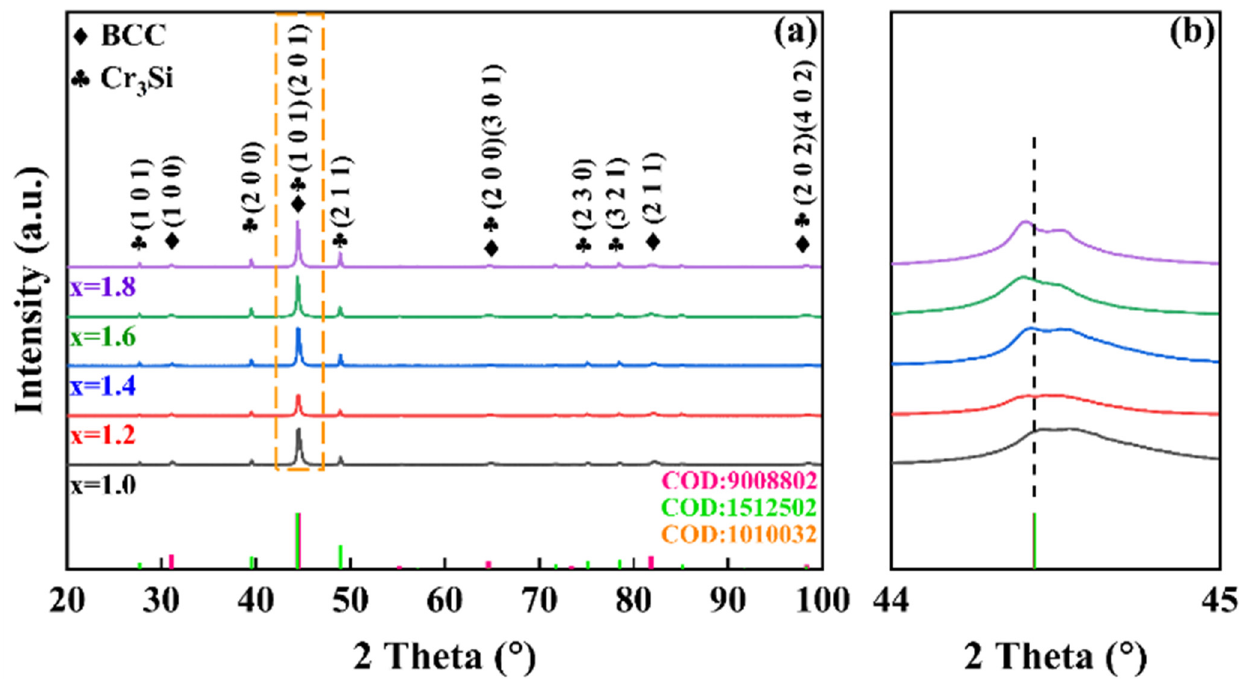
Figure 1. XRD patterns of AlSi 0.5 Cr x Co 0.2 Ni (x = 1.0, 1.2, 1.4, 1.6, and 1.8) high entropy alloys; ( a ) The phase composition of AlSi 0.5 Cr x Co 0.2 Ni HEAs, ( b ) The enlarged image of the strongest diffraction peak.